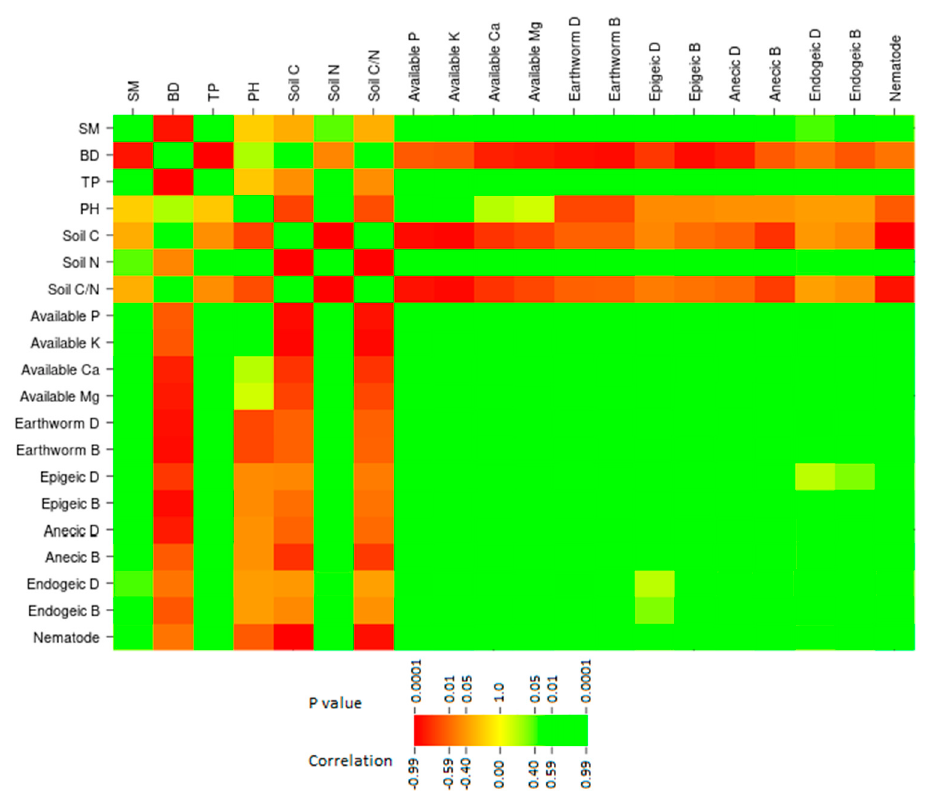
Figure 6. Pearson correlation coefficients (heat map) between soil physicochemical and biological